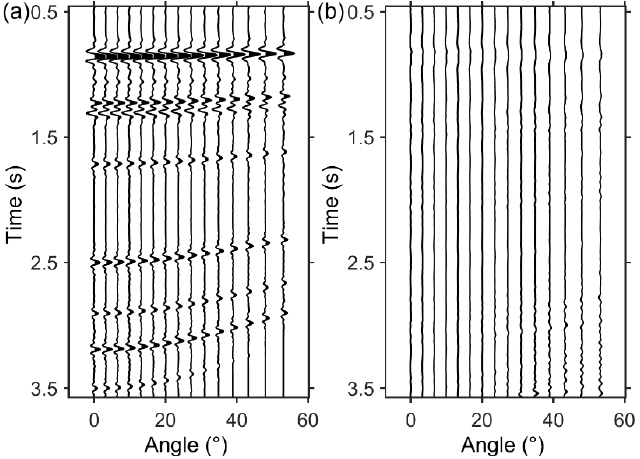
Figure 12. ( a ) Synthetic seismic angle gathers at 2.25 km after the wave-equation-based inversion method, ( b ) difference between the real seismic gather in Figure 3b and synthetic seismic gather in ( a ).